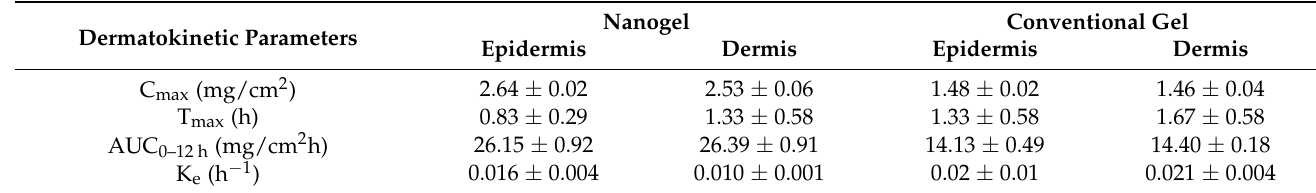
Figure 5. Dermatokinetic profile (mean ± SD), demonstrating lidocaine concentration in ( a ) epidermis and ( b ) dermis. Table 5. Outcomes of various dermatokinetic parameters (mean ± SD) of lidocaine-loaded gel formulations.